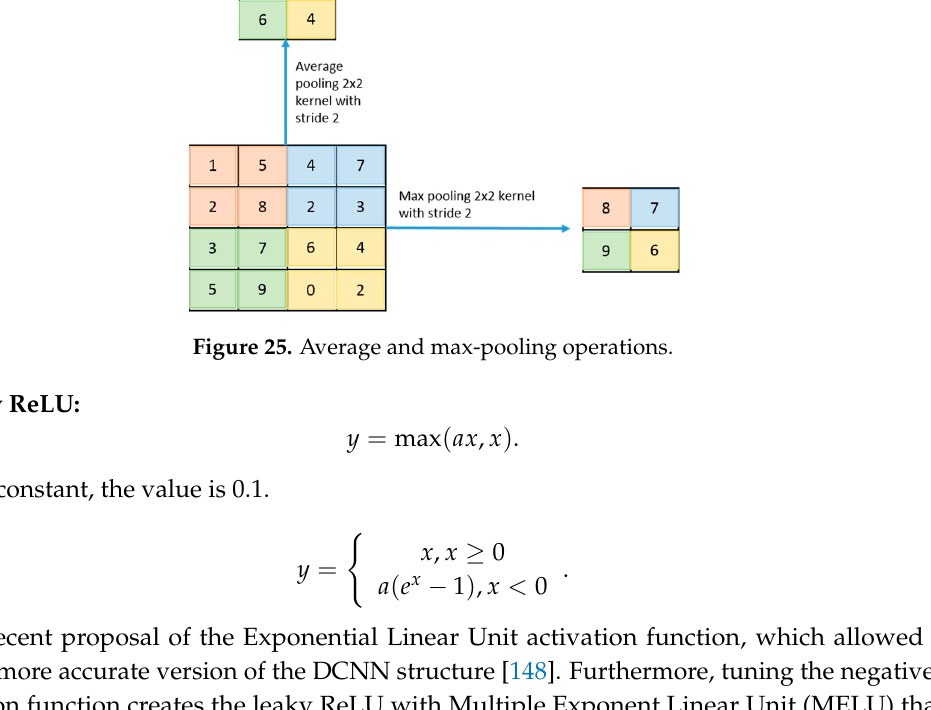
Figure 26. Spatial pyramid pooling. 4.7. Regularization Approaches for DL There are different regularization approaches that have been proposed in the past few years for deep CNN. The simplest but efficient approach called dropout was proposed by Hinton in 2012 [156]. In Dropout, a randomly selected subset of activations is set to zero within a layer [157]. The dropout concept is shown in Figure 27.